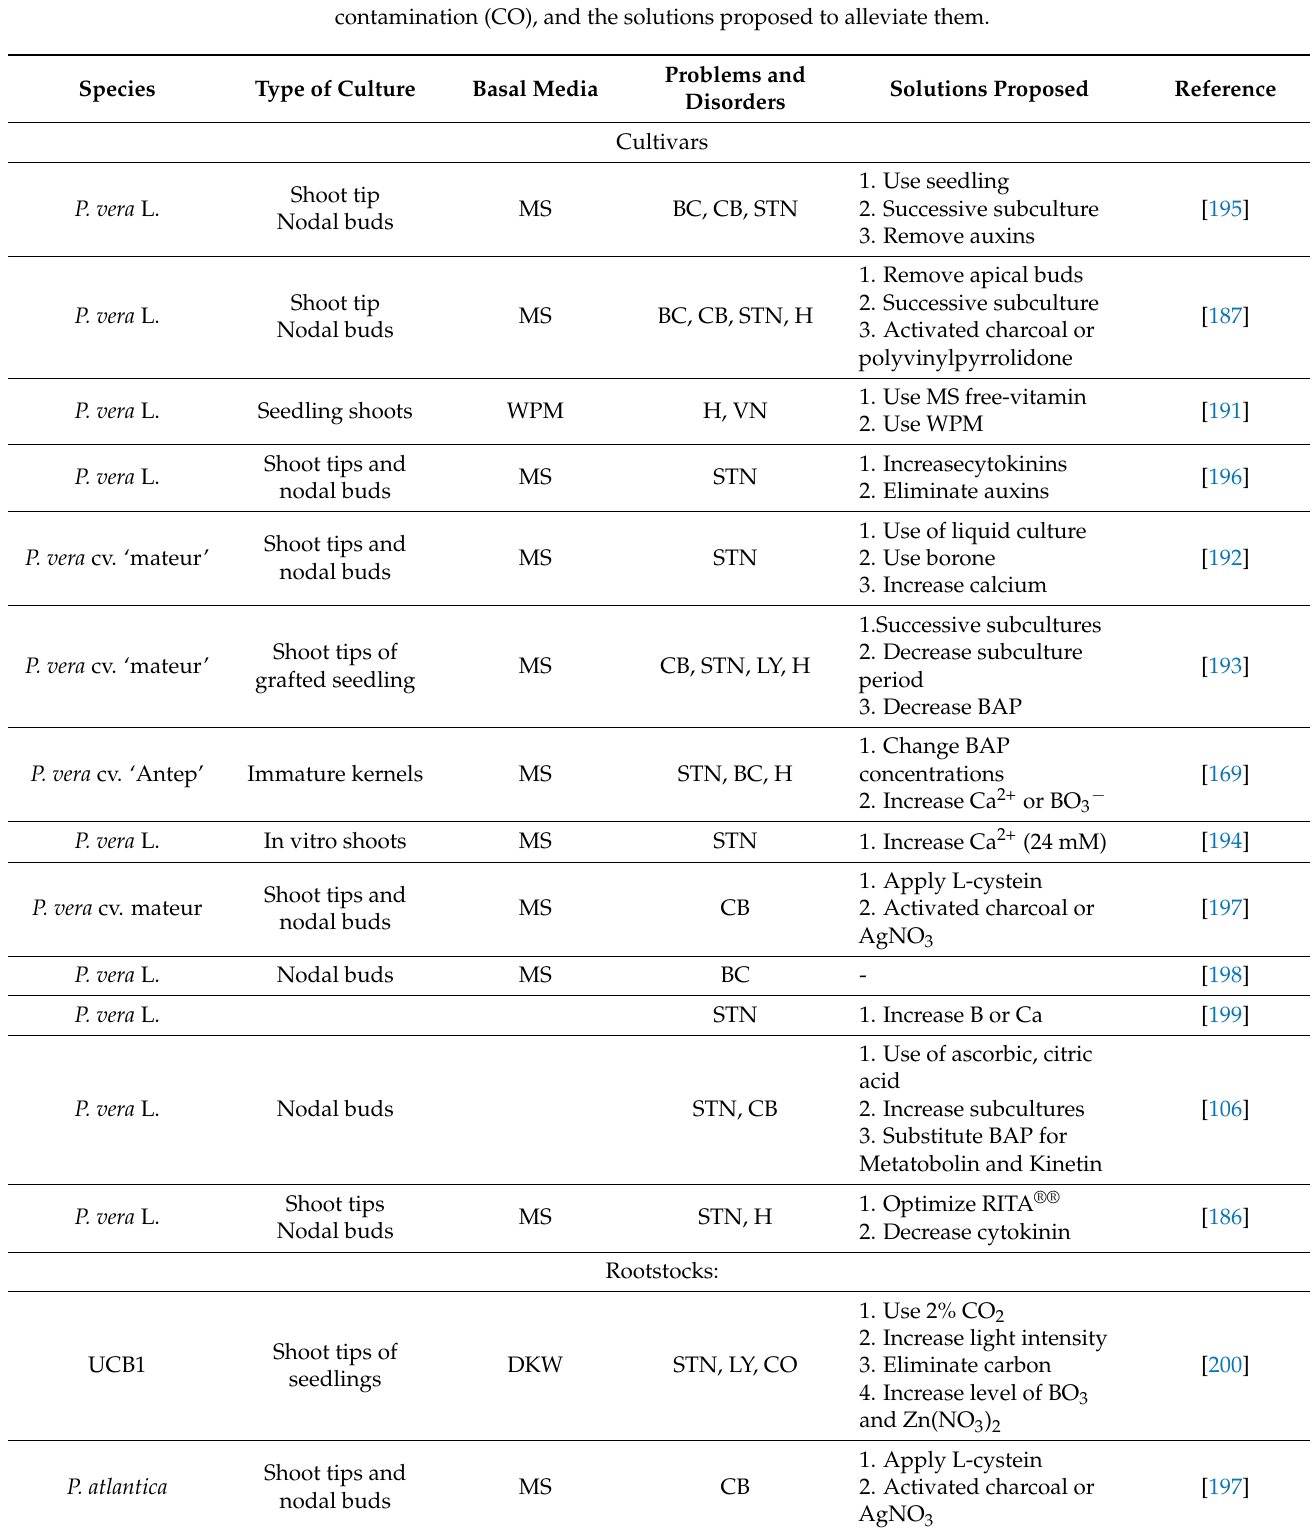
Table 3. Main studies on Pistacia spp. micropropagation indicating basal culture media employed, physiological disorders such as basal callus (BC), shoot tip necrosis (STN), hyperhydricity (H), Leaf yellowing (LY), and vascular necrosis (VN) and some problems such as culture browning (CB) and contamination (CO), and the solutions proposed to alleviate